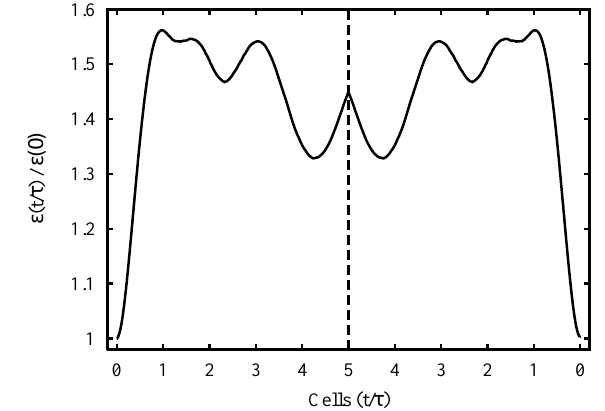
FIG. 2. Emittance growth factors versus the number of cells obtained for a nonstationary initial phase space density at s 0 (cid:1) 60 ± , s (cid:1) 15 ± , 2500 simulation particles. The dashed line marks the point of the time reversal after five cells.